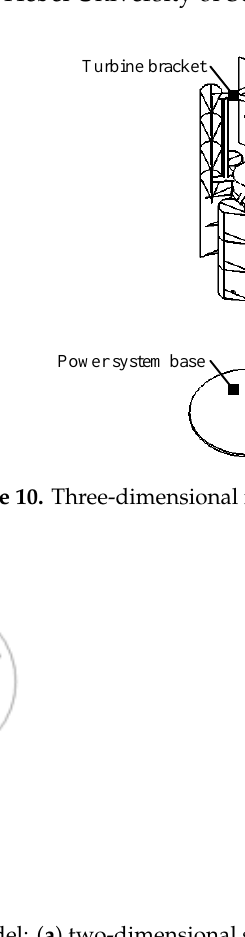
Figure 11. Wind wheel model: ( a ) two-dimensional structural model of the double-layer wind wheel; ( b ) 3D structural model of the one-layer wind wheel. Table 4. Specific parameters of the wind turbine.